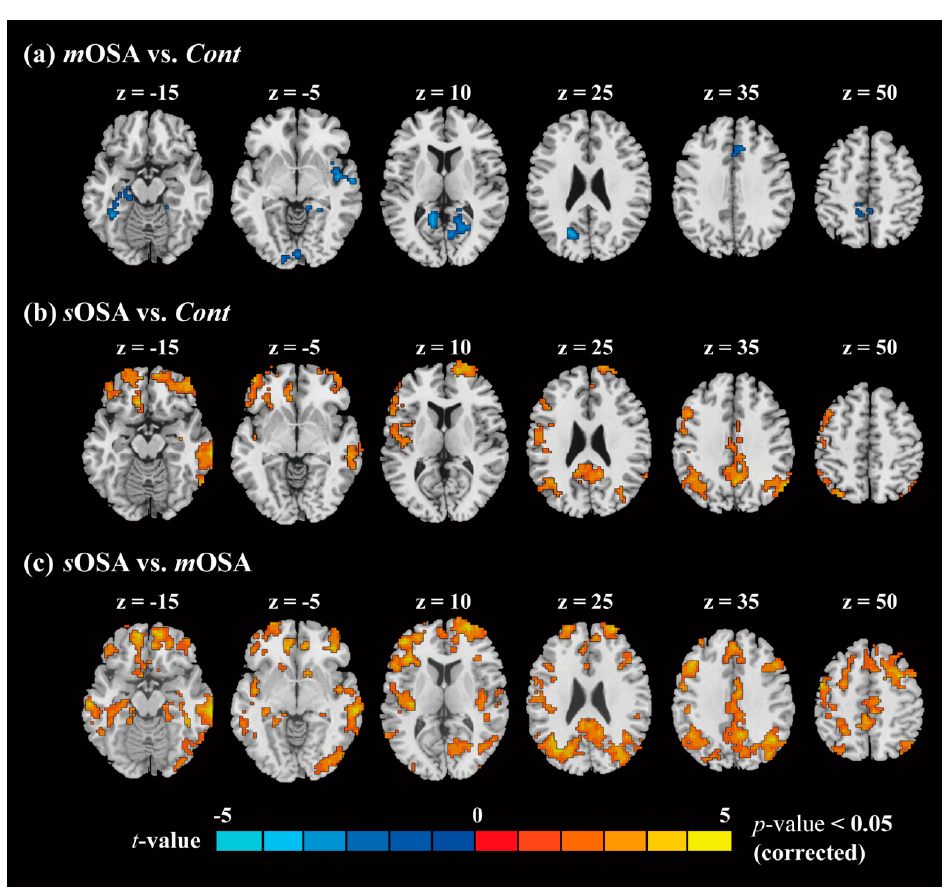
Figure 2. Differences in functional connection between pairs of two groups. Two-sample t -tests were performed on the functional connectivity data to assess the cognitive influence between all pairs of two groups as follows: ( a ) m OSA vs. Cont ; ( b ) s OSA vs. Cont ; ( c ) s OSA vs. m OSA. The contrast activations are below the level of statistical significance ( p < 0.05). Abbreviations: Cont , Control group; m OSA, moderate OSA group; s OSA, severe OSA group; OSA, obstructive sleep apnea.